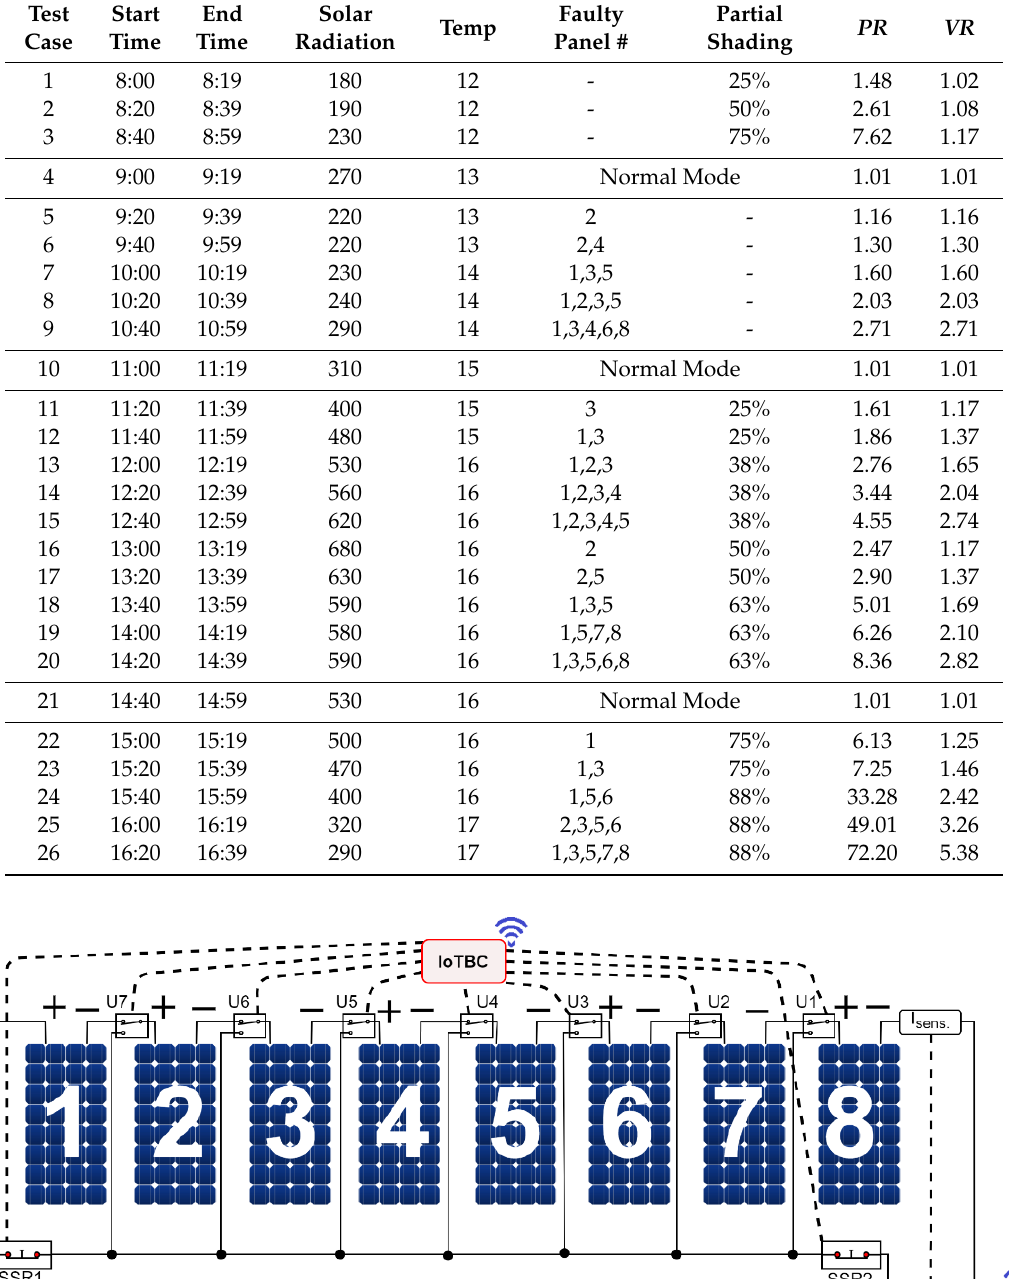
Table 6. Execution time and accuracy results from NARX network hardware implementation.